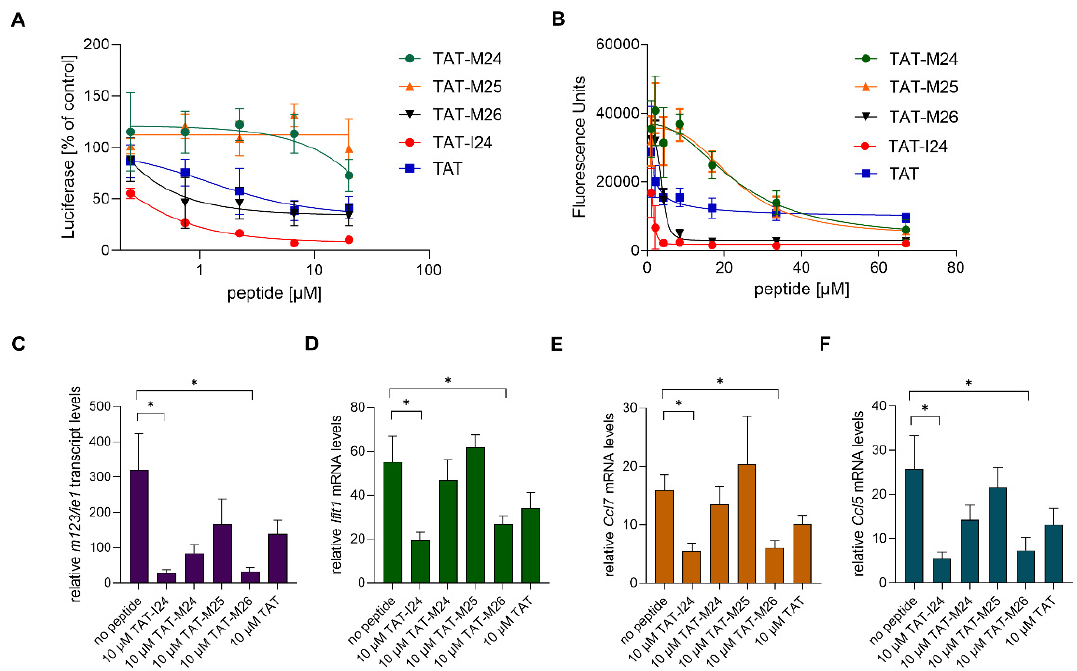
Figure 5. ( A ) Effect of peptides on luciferase reporter gene expression in NIH/3T3 cells infected with MCMV 72 h post-infection. Results shown are mean ± standard deviation from three independent experiments performed in duplicates for TAT-M24, TAT-M25 and TAT-M26. For comparison, TAT- I24 and TAT were included. ( B ) Fluorescence reduction of SYBR ® Gold-stained plasmid-DNA by various peptides. Results shown are mean ± standard deviation from three independent experiments performed in duplicates. ( C – F ) Levels of host-cell transcripts relative to the housekeeping gene Gapdh in NIH/3T3 cells infected with MCMV (MOI 1) 2 h post-infection. Results shown are fold change of transcript levels (mean ± standard error of the mean) of m123/ie1 ( C ), Ifit1 ( D ), Ccl7 ( E ) and Ccl5 ( F ) from four independent experiments. Multiple t-test was used for statistical analysis; * statistically significant at p ≤